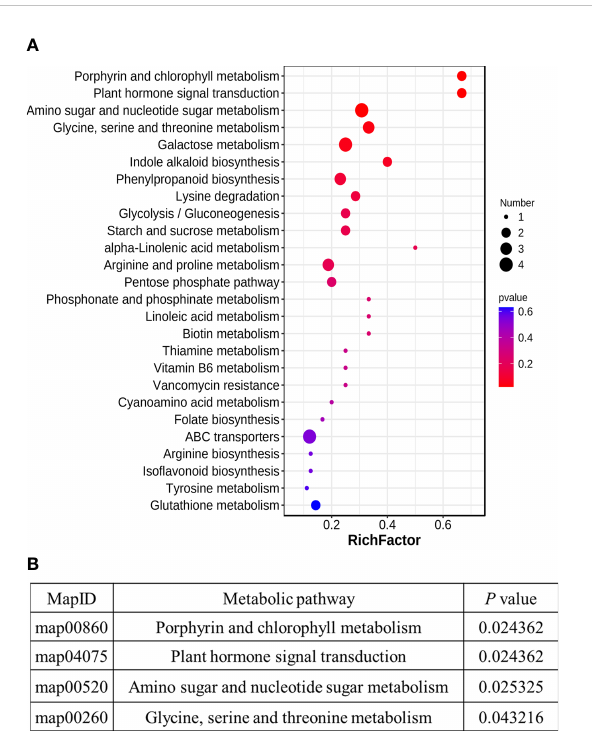
FIGURE 4 The Kyoto Encyclopedia of Genes and Genomes (KEGG) analyses of differential metabolites between normal condition and high- temperature stress. (A) KEGG enrichment of annotated metabolites from normal condition and high-temperature stress. The y -axis indicates the KEGG pathway and the x -axis indicates the enrichment factor. (B) Signi fi cant difference in KEGG pathway